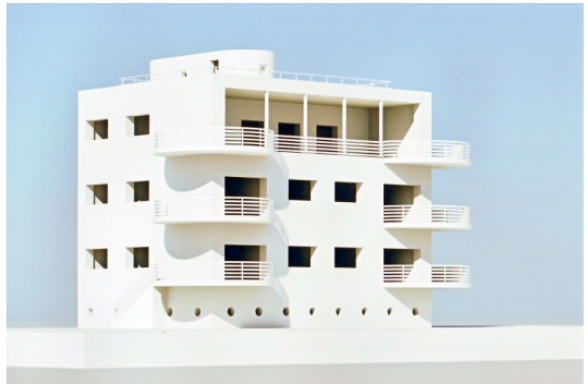
Figure 10. Ostia Lido. 3D Model of the detached house by A. Libera in Piazza